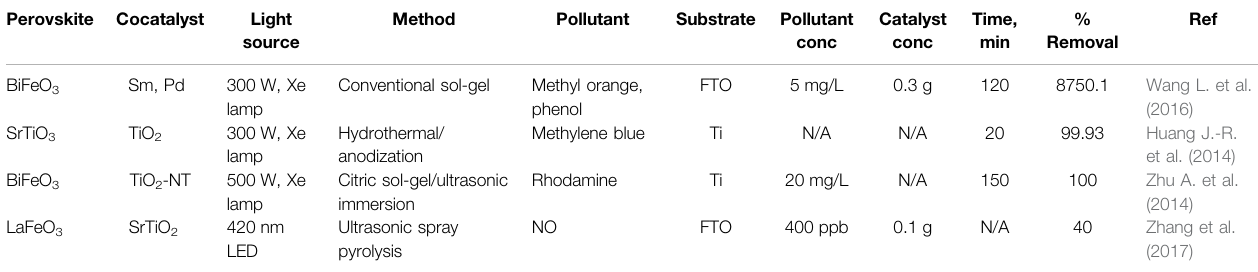
TABLE 2 | Recent perovskites in photoelectrocatalysis for water